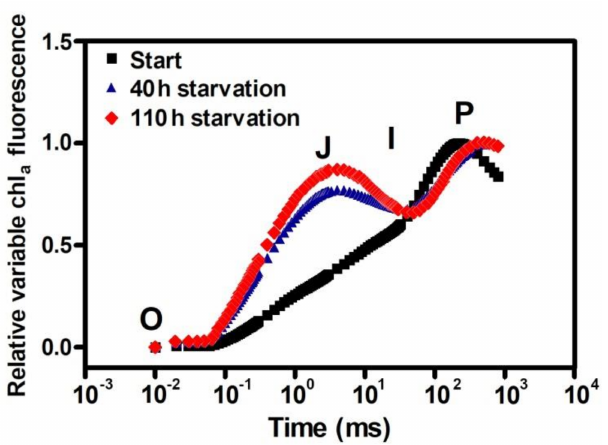
Figure 6. Effect of sulfur deprivation on the chlorophyll a fluorescence transient in C. reinhardtii cultures. Start (dark squares); 40 h of sulfur deprivation (blue triangles); 110 h of sulfur deprivation (red diamonds). Relative variable fluorescence (V t = (F t − F 0 )/(F m − F 0 ))